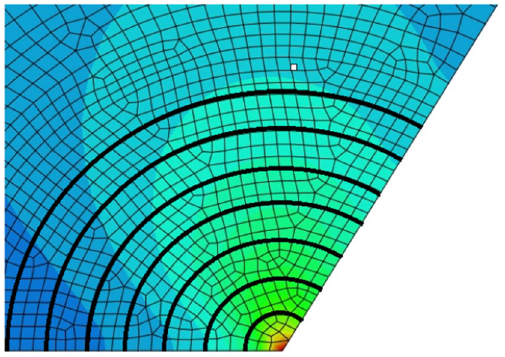
Fig. 13 The 𝜎 y stress gradient and radial layering around crack